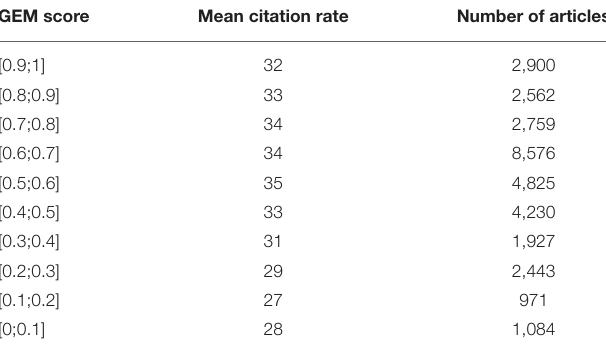
TABLE 7 | GEM score and mean citation